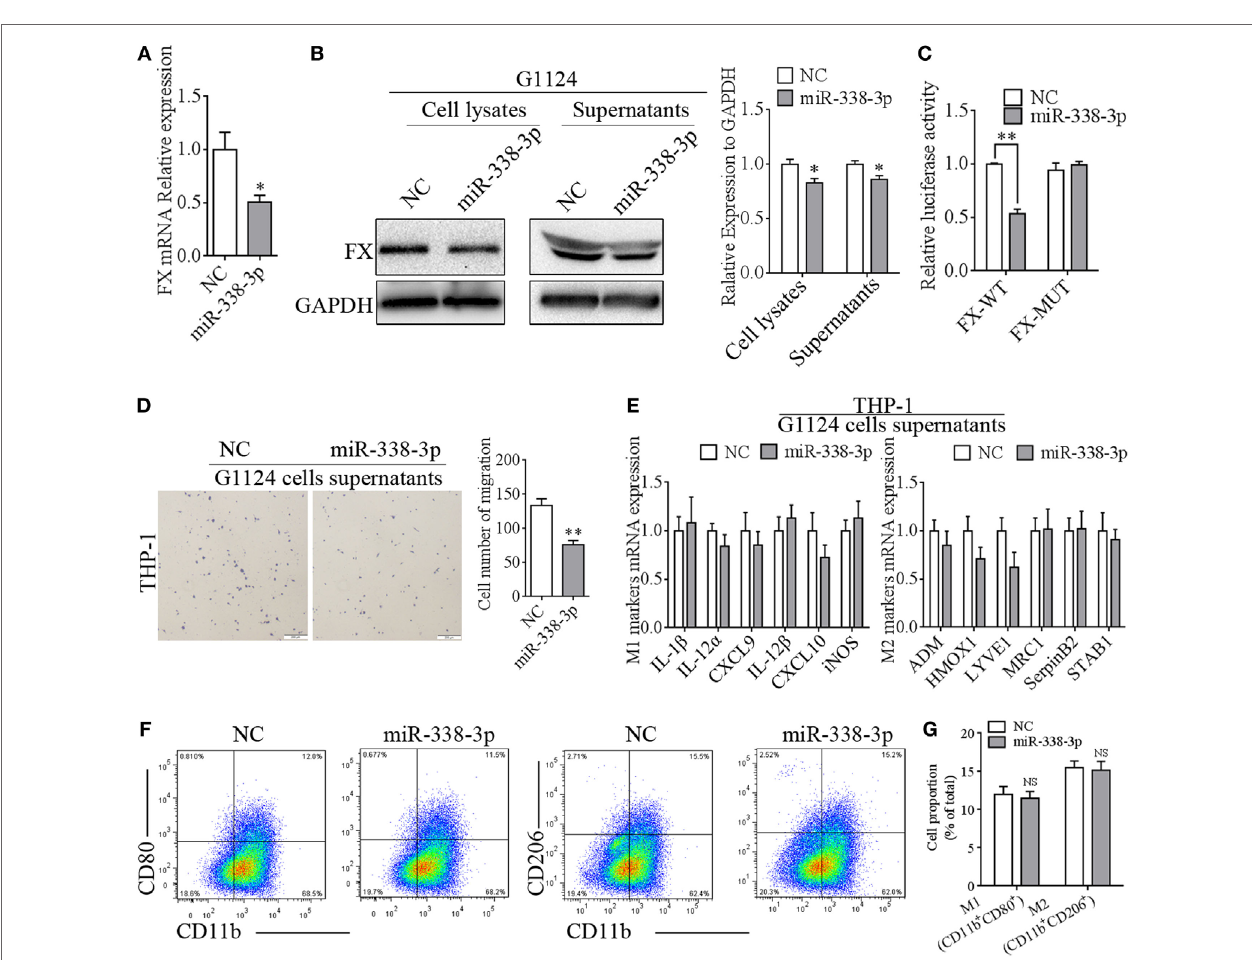
FigUre 6 | miR-338-3p targeted factor X (FX) to suppress macrophage migration. (a) Real-time PCR detected that the mRNA expression of FX decreased after transfection with miR-338-3p mimics in G1124 cells (mean ± SEM, * p < 0.05). (B) Western blotting detected reduced FX expression in cell lysates and supernatants after G1124 cells were transfected with miR-338-3p mimics. (c) The luciferase reporter assay showed that miR-338-3p decreased luciferase activity (mean ± SEM, ** p < 0.01). (D) The number of phorbol 12-myristate 13-acetate (PMA)-primed THP-1 cells migrating toward G1124 cell supernatants decreased when G1124 cells were transfected with miR-338-3p mimics (mean ± SEM, * p < 0.01). (e) Real-time PCR detected the expression of M1 and M2 markers in THP-1 cells after incubation with G1124 cell supernatants transfected with NC or miR-338-3p mimics (mean ± SEM). (F,g) Flow cytometry analysis showed that the proportion of CD11b + CD80 + M1 macrophages and CD11b + CD206 + M2 macrophages did not changed in THP-1 cells treated with supernatants from G1124 cells transfected with miR-338-3p compared with NC. (g) Bar graph of CD11b + CD80 + and CD11b + CD206 + cell proportion in panel (F) .